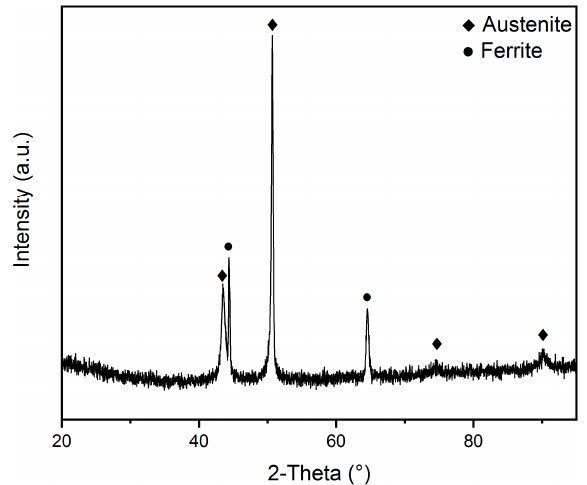
Figure 8. X-ray diffraction analysis result of as-deposited sample.